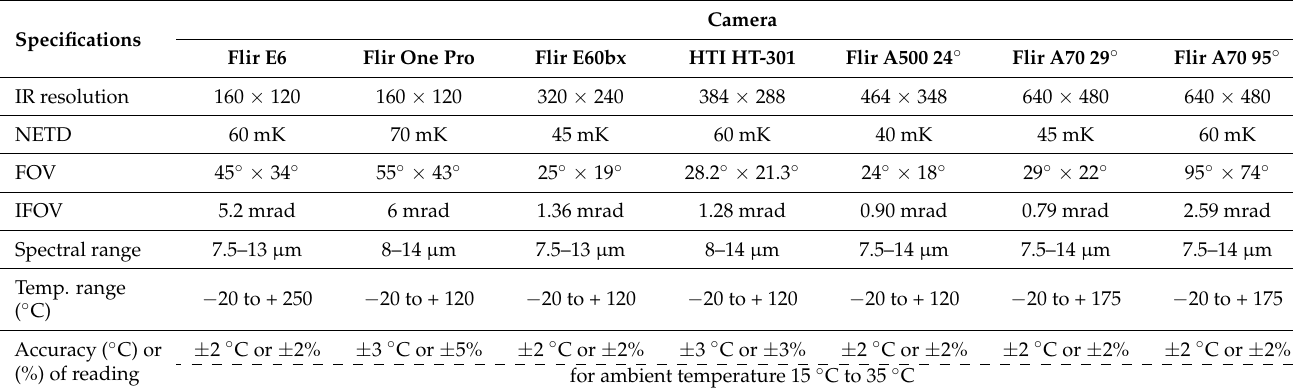
Table 3. Comparison of infrared thermal cameras used for imaging and analysis.